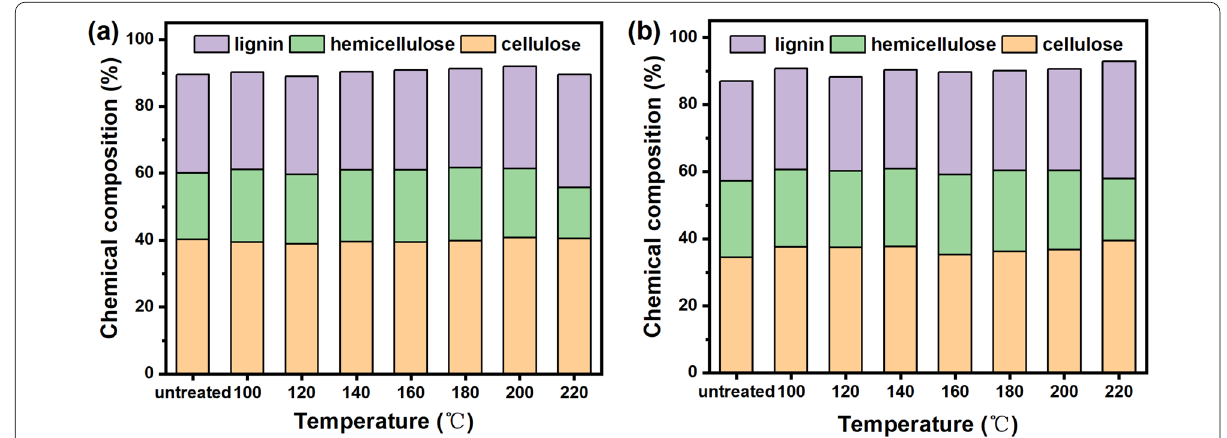
Fig. 7 Chemical compositions in a fibers and b parenchyma